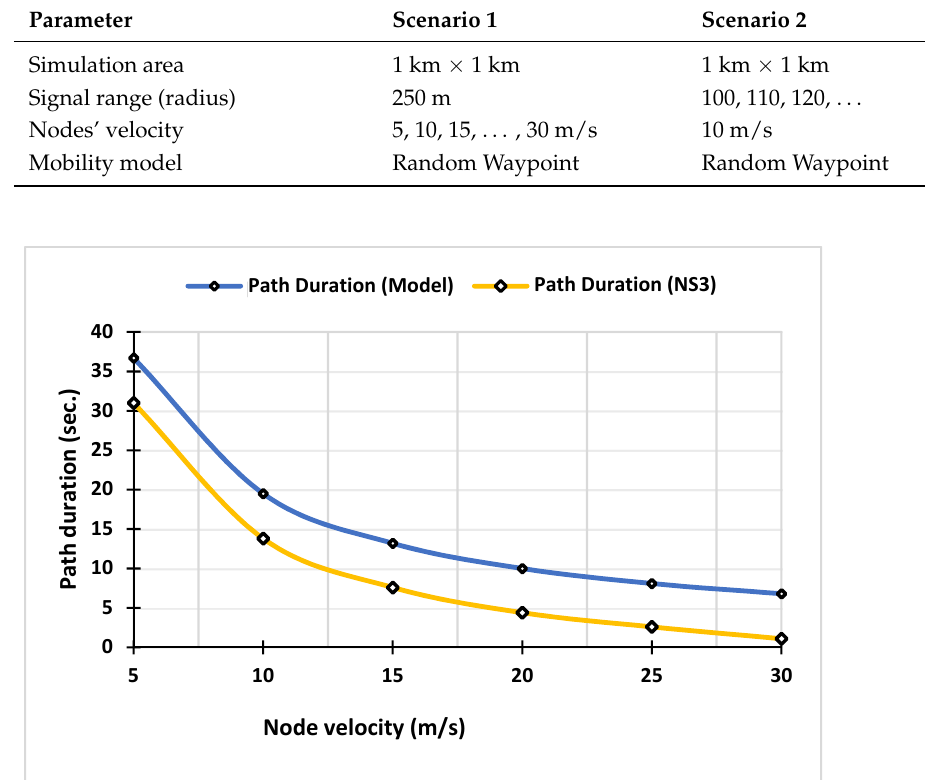
Figure 9. The path duration vs. and the node velocity.